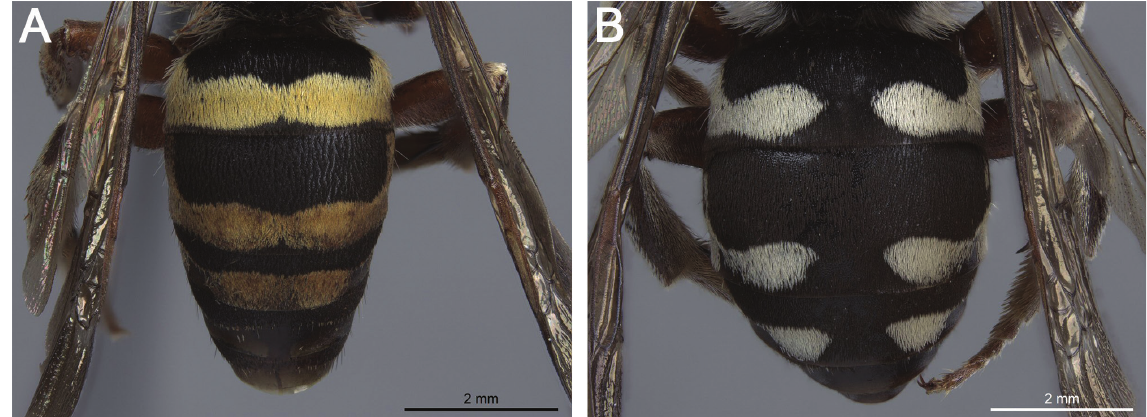
Fig. 9. Metasoma of male, dorsal view. A . Brachymelecta haitensis (Michener, 1948) (JAG). B . B. tibialis (Fabricius, 1793)